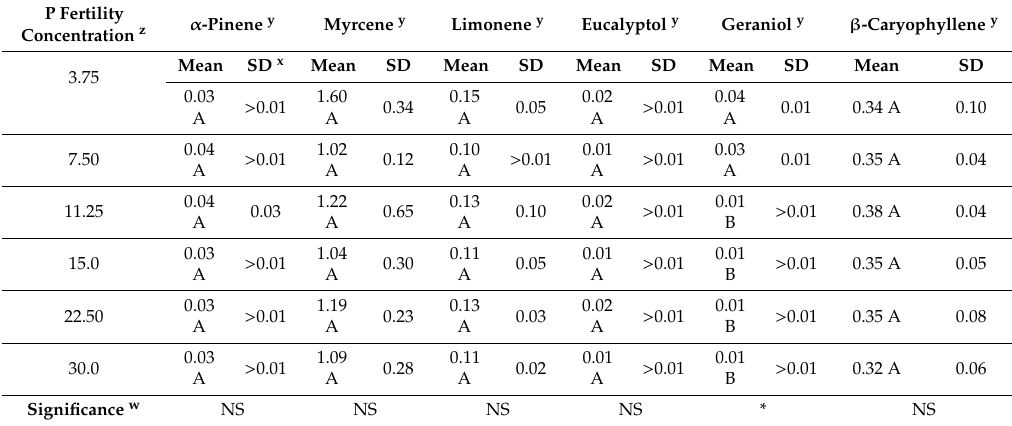
Table 9. The impacts of phosphorus (P) fertility on the terpene concentration of C. sativa “BaOx” floral material after eight weeks of critical night length (CNL)